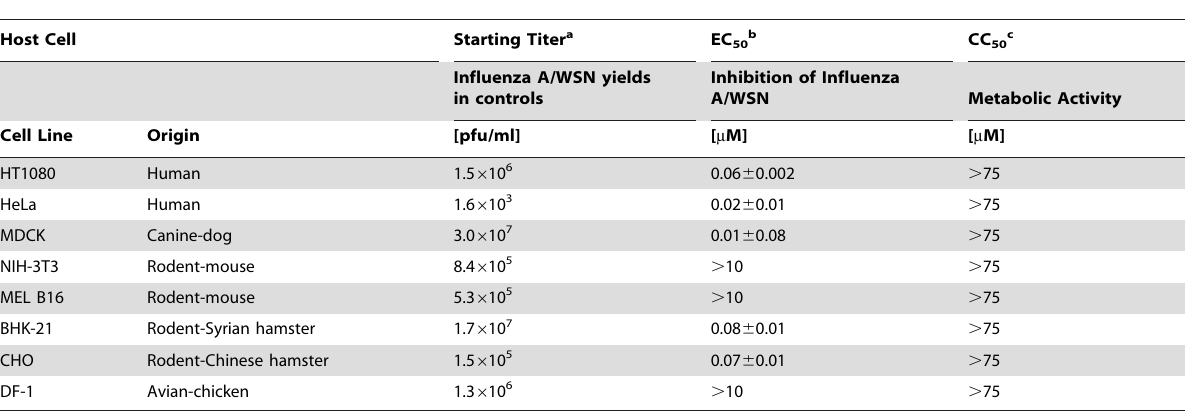
Table 2. Antiviral activity of JMN3-003 is host cell species-specific.